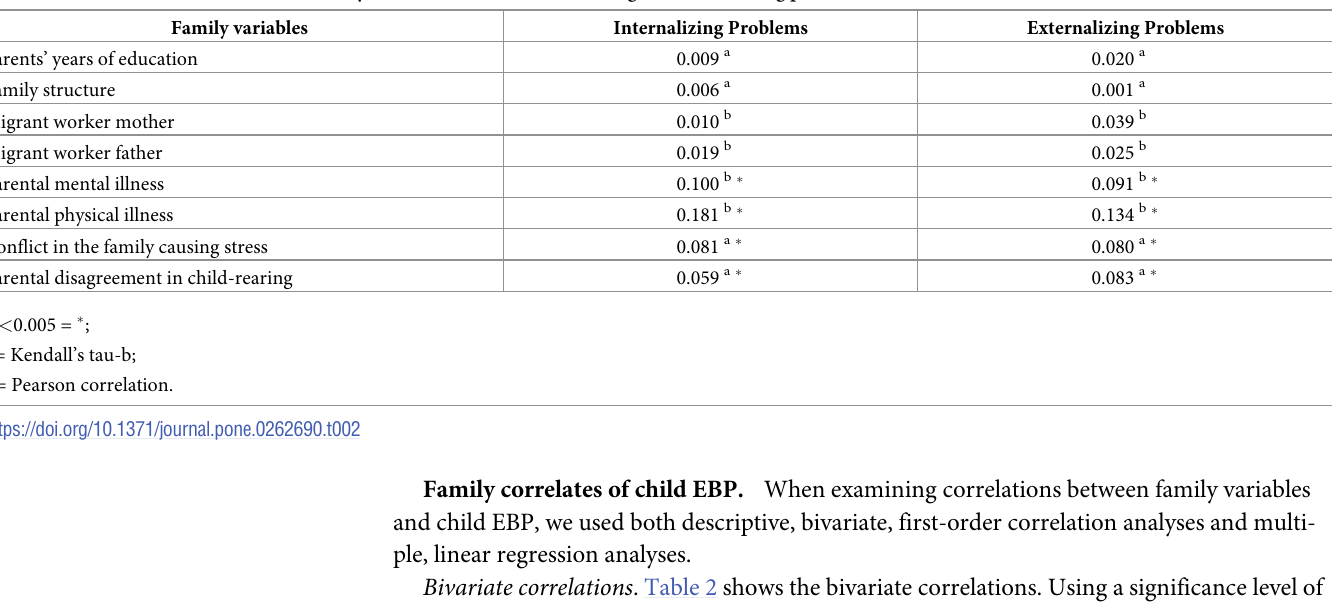
Table 2. Bivariate correlations between family variables and child internalizing and externalizing